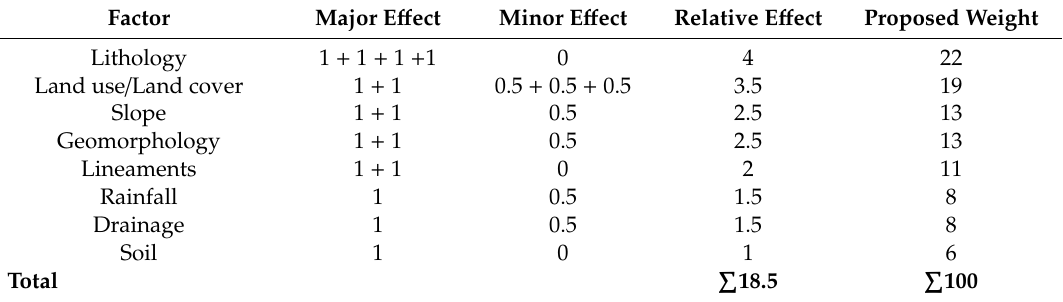
Table 7. The values of major, minor, relative effects and proposed weight of influencing factors.